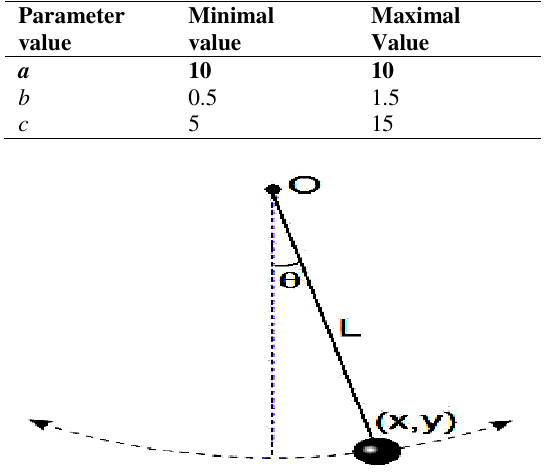
The maximum and minimum pendulum parameters